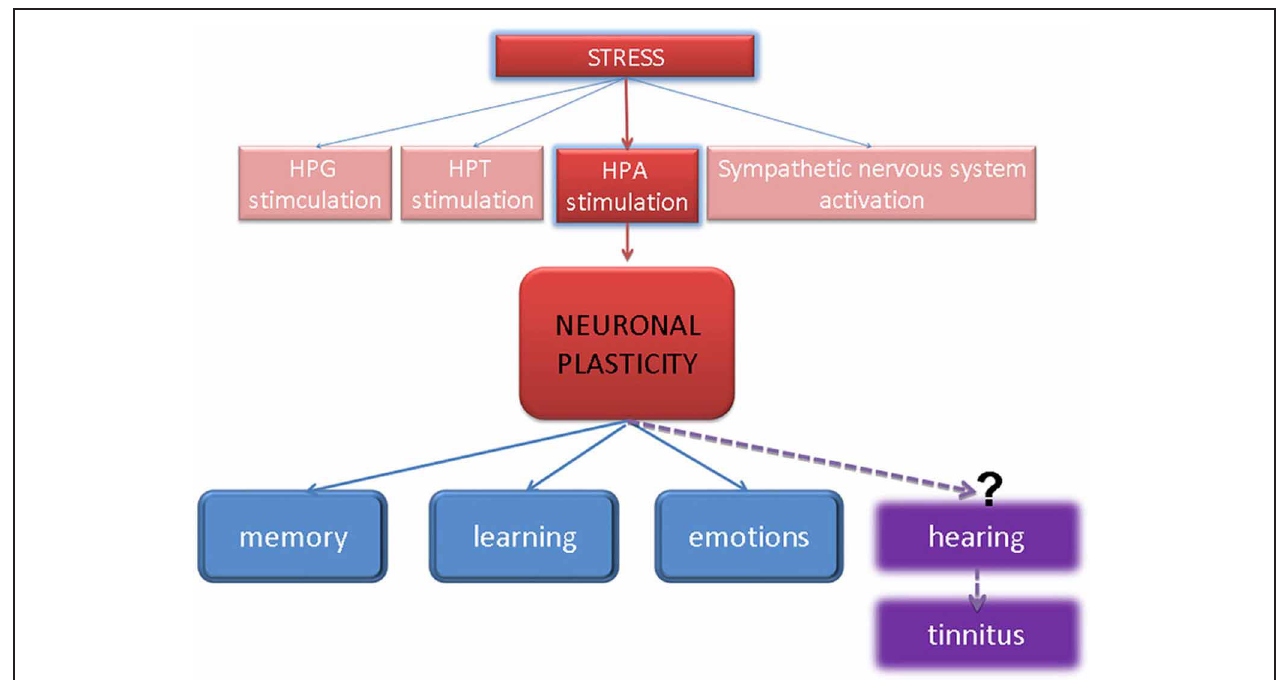
FIGURE 5 | Model of stress-induced neuronal plasticity, which has been accepted in memory, learning, and emotional systems—can it also be truth to explain the induction of auditory pathologies by stress?